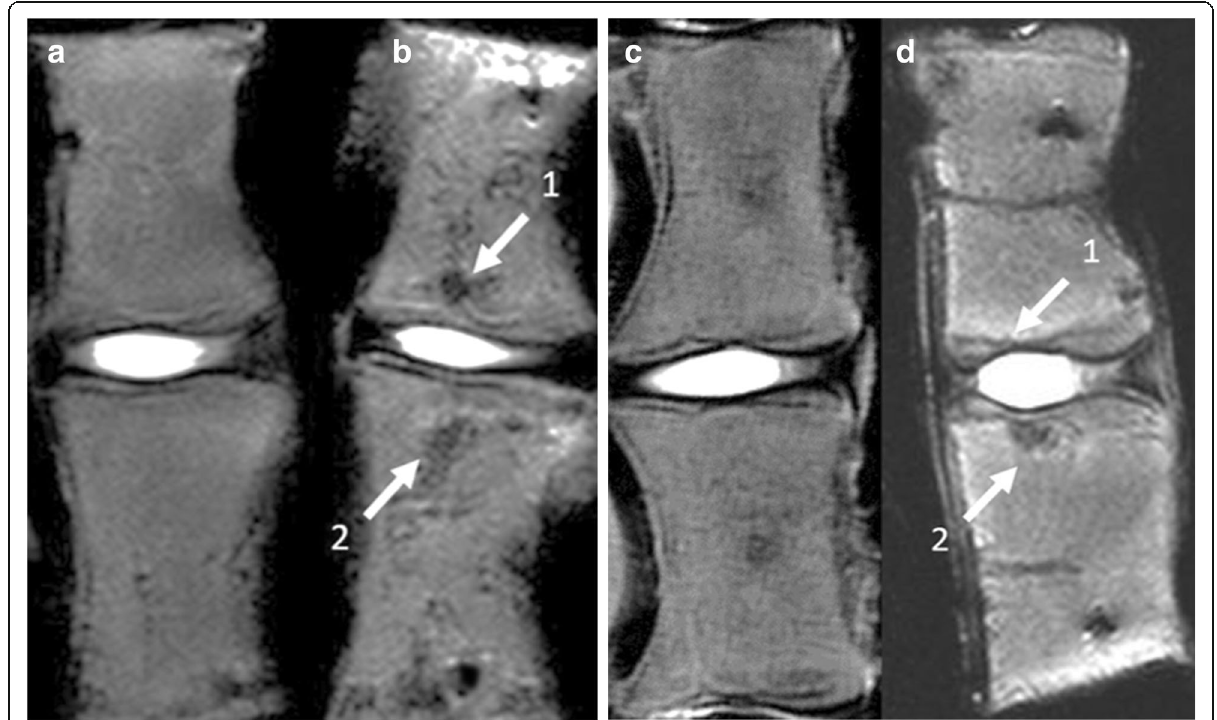
Fig. 3 Un-loaded control ( a ) and FSU after repetitive flexion ( b ). Decreased signal in both the superior (1) and inferior growth zones (2) and endplates in the flexed FSU. Un-loaded control ( c ) and FSU after repetitive extension ( d ). Reduced signal in the superior growth zone (1) and in inferior end plate (2) in the extended